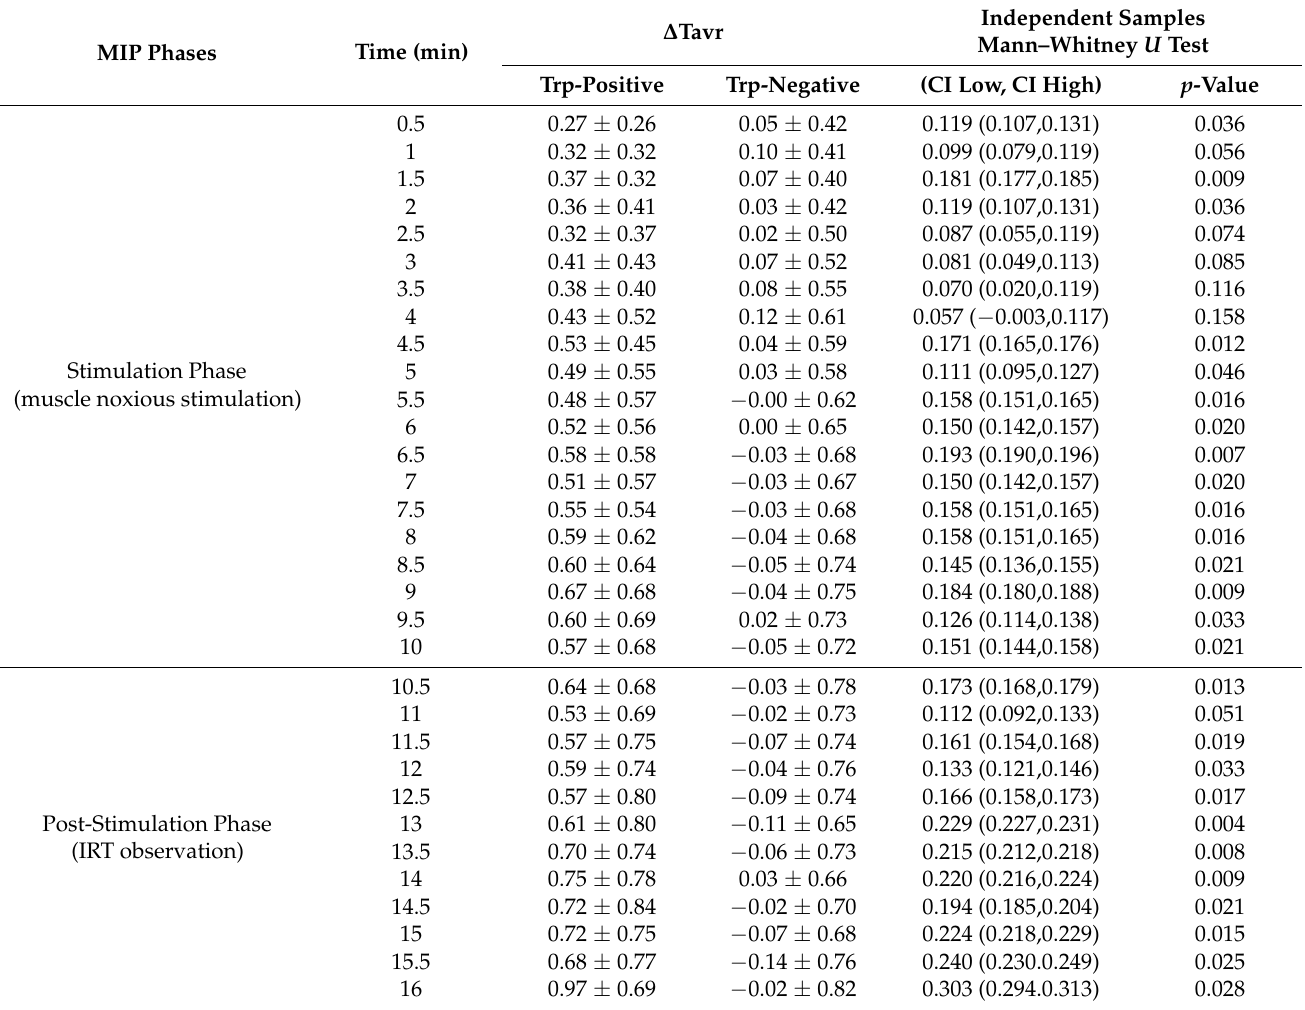
Table 1. Detailed average temperature changes in the thigh ROI observed every 30 s of the